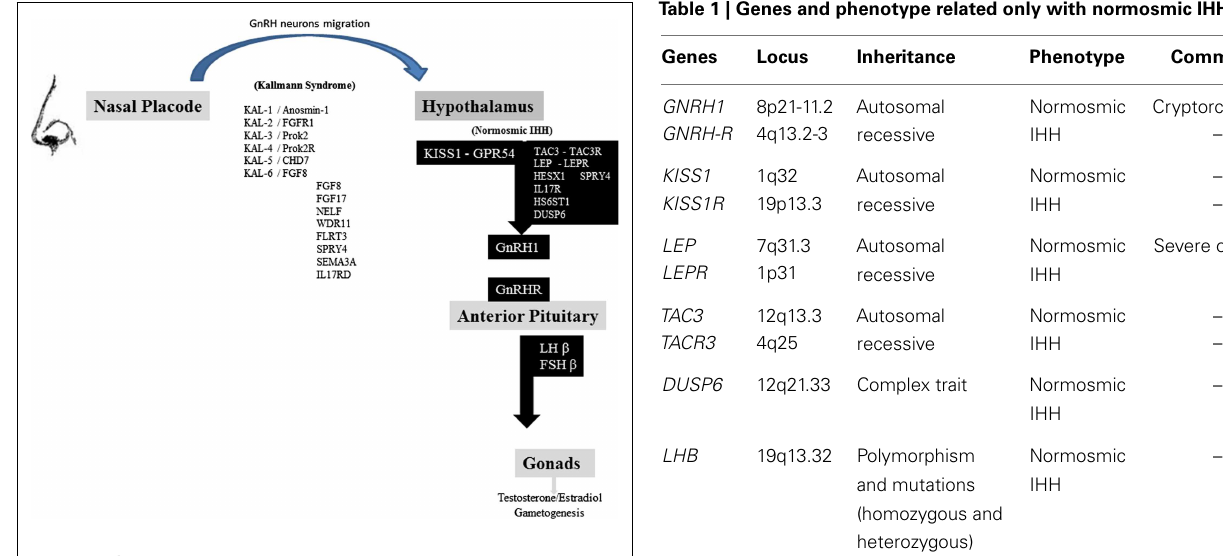
FIGURE 1 | Schematic representation of the reproductive axis and the different genes invalidating mutations participating in Kallman syndrome and nIHH . GnRH neurons migrate from nasal placode to hypothalamus in the first weeks of fetal life. Several genes are represented in the left column: their invalidating mutations are responsible for Kallmann syndrome and olfactory dysfunction. Kiss1 neurons integrate different hormonal, metabolic, circadian inputs from other hypothalamic and brain areas and thus stimulate GnRH neurons firing. Several genes are represented in the right black column, including KISS1-GPR54 system, which invalidating mutations lead to normosmic idiopathic hypogonadotropic hypogonadism. GnRH secretion leads to gonadotropins FSH and LH pituitary release. LH and FSH control sex steroids secretion and gametogenesis [adapted fromValdes-Socin et al. (1), with permission].